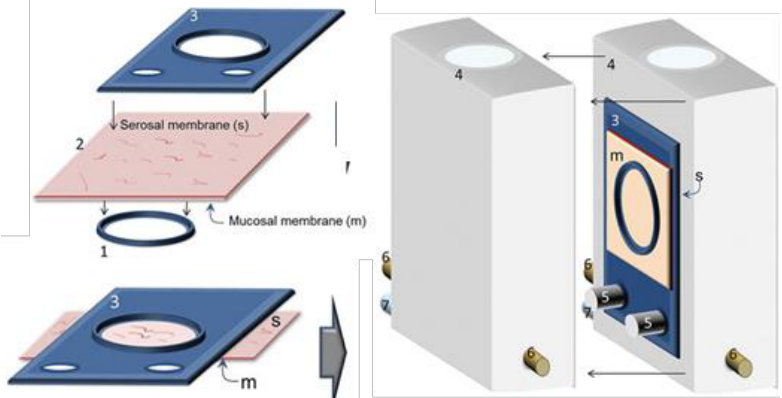
Figure 3. Schematic view of tissue fixation in the Ussing chamber. After the removal of the muscle layer, fat, and sub-mucosa, the tissue clamp is pushed carefully under the intestinal segment. The mucosal side (m) faces the bottom and the serosal membrane (s) faces the top. Then, the tissue holder is pressed down onto the tissue, fixing the tissue in-between the tissue holder and the tissue clamp. After the removal of overlapping tissue, the tissue holder is mounted into the Ussing chamber (4) by fixing it onto the bars (5). The mucosal side can face the left or the right half of the chamber (here the mucosal side faces the left). 6 = connectors for agar-salt bridges; 7 = connectors for carbogen. Adopted with permission from [185], John Wiley & Sons,